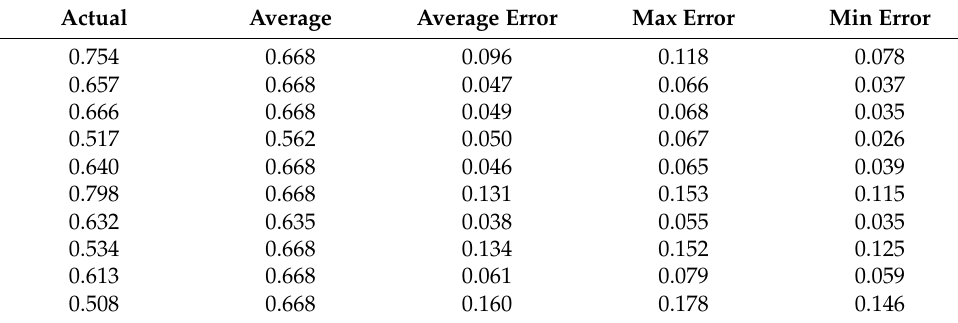
Table A125. Set 2, trials 31–40 data (single 0.5 PR